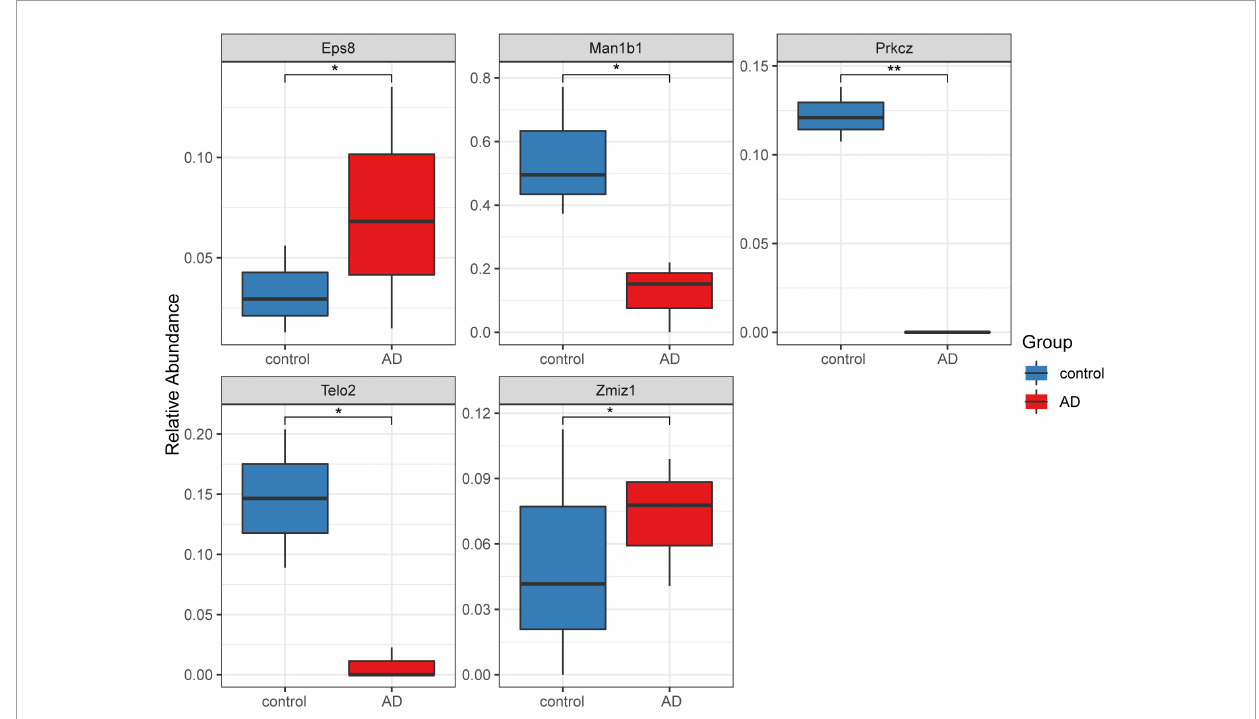
FIGURE6 Five significantly expressed genes in the Alzheimer’s disease (AD) model mice compared with the control group. Five of the 14 genes had a significant expression level among the AD and control groups (* P < 0.05 and ** P < 0.01). The red and blue boxes represent the AD and control mice,